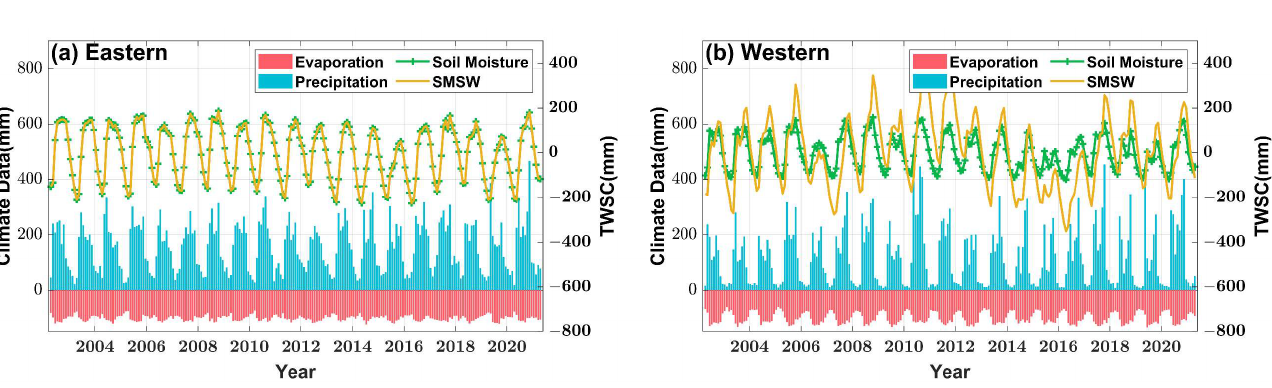
Figure 6. The monthly variation of SMSW, soil moisture, precipitation, and evaporation in east- ern ( a ) and western ( b ) Nicaragua, respectively. To better visualize the results, we multiplied the evaporation by −